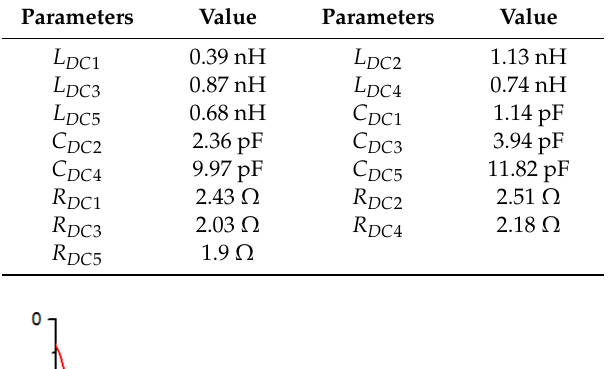
Table 2. Parameters of 5 order L-resonant circuit.